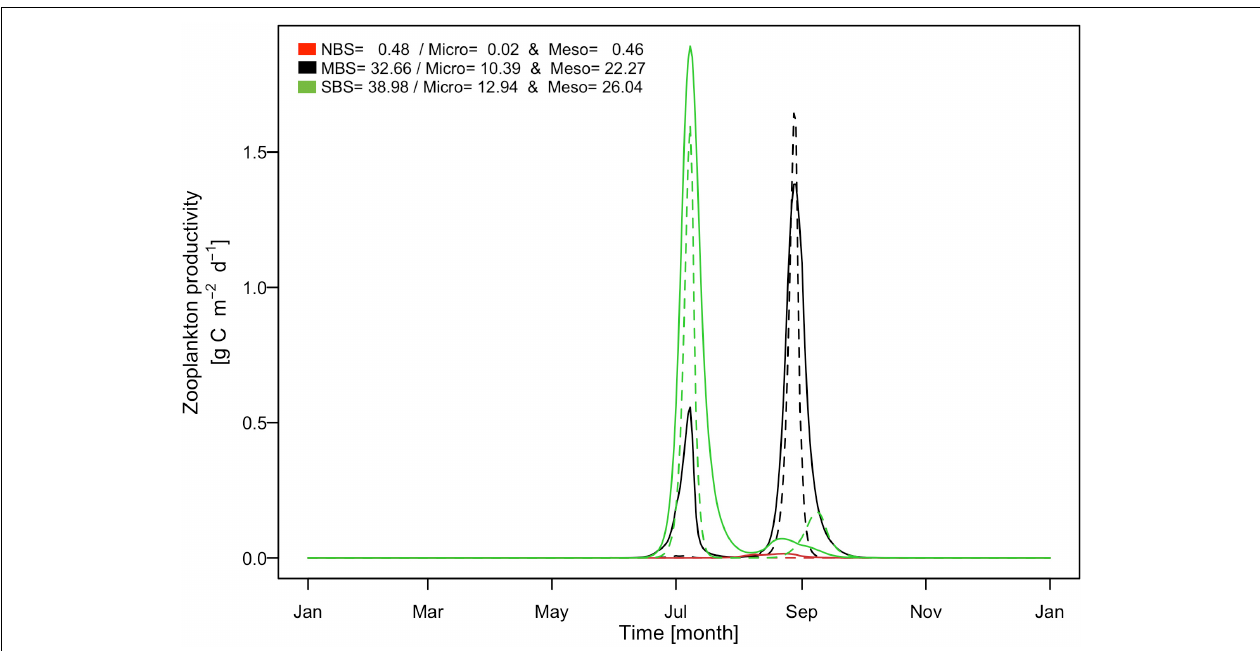
FIGURE 9 | Simulated time series of production rates of zooplankton including mesozooplankton (solid line) and microzooplankton (dashed line). Black color presents result for the central Barents Sea station over the 1997, red color for the north Barents Sea station over the 1997, and green color for the south Barents Sea station over the 1997. In the legend are indicated the annual production in gC m − 2 for zooplankton including microzooplankton (Micro) and mesozooplankton (Meso).